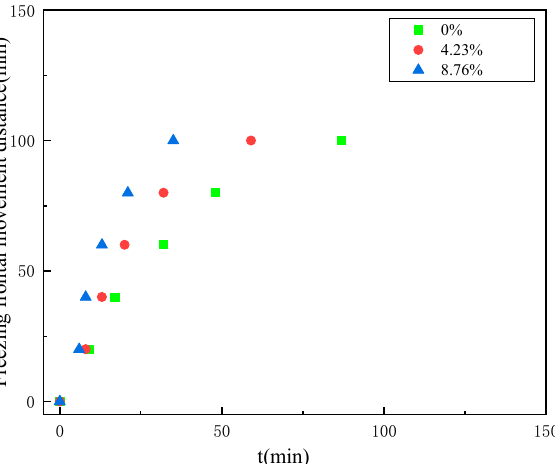
Figure 7. The movement of the freezing front under different water content conditions.